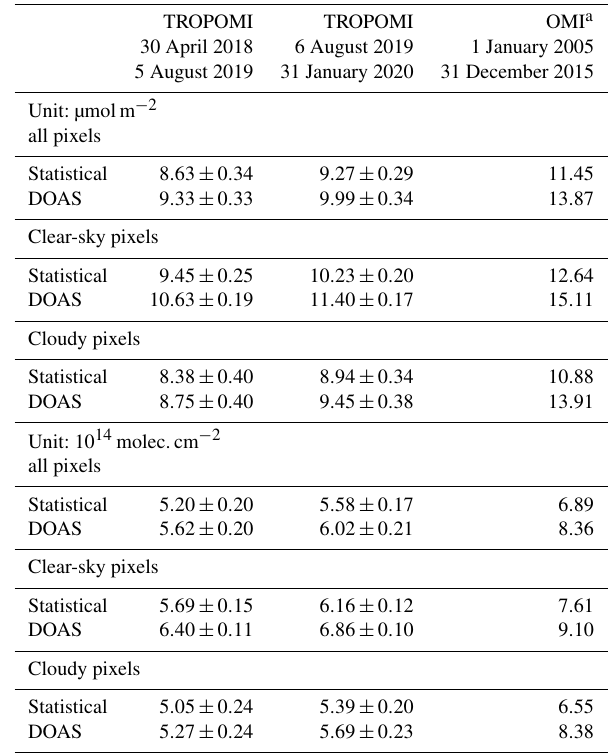
Table 3. NO 2 SCD statistical and SCD DOAS fit uncertainties, av- eraged over the listed period, given in two units; cf. Fig.